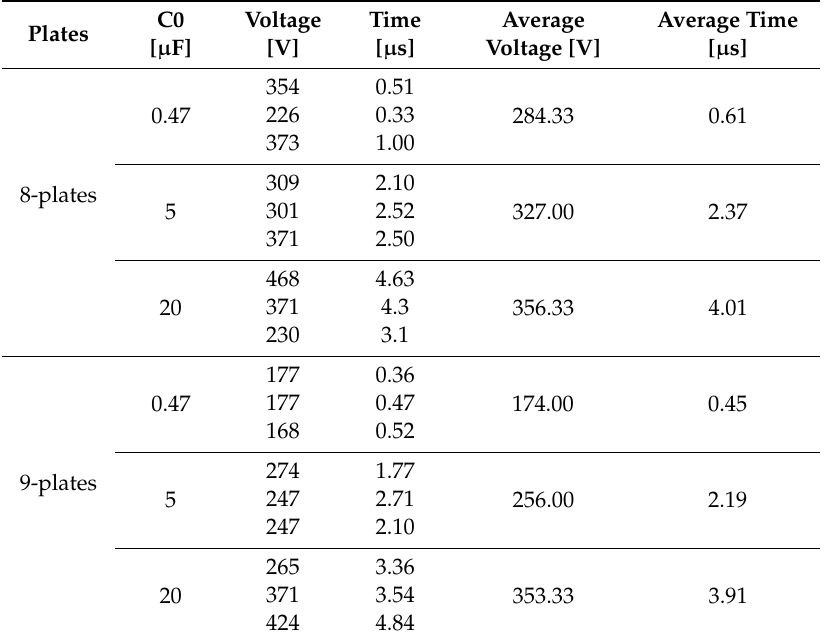
Table 3. Test results according to plate